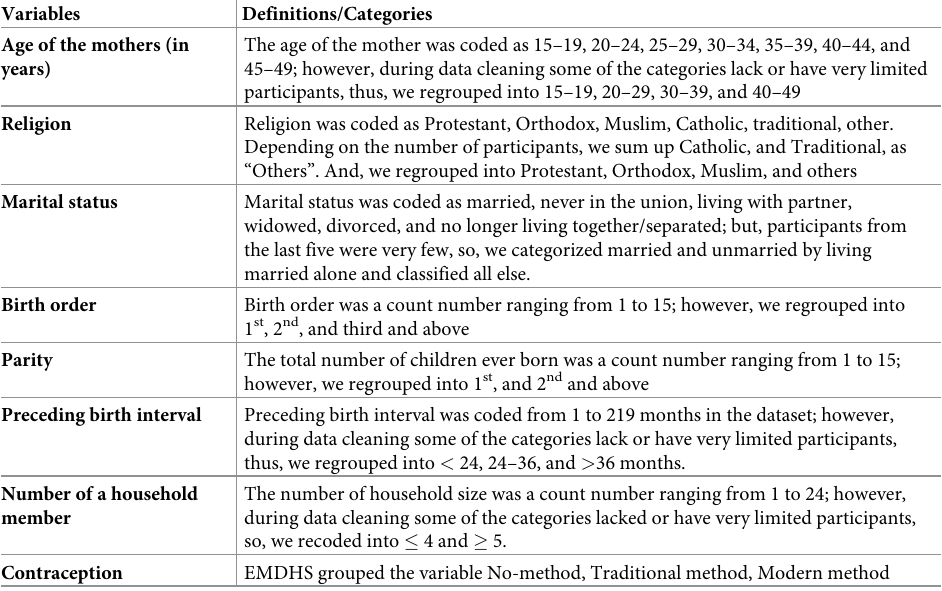
Table 1. The description of some of the independent